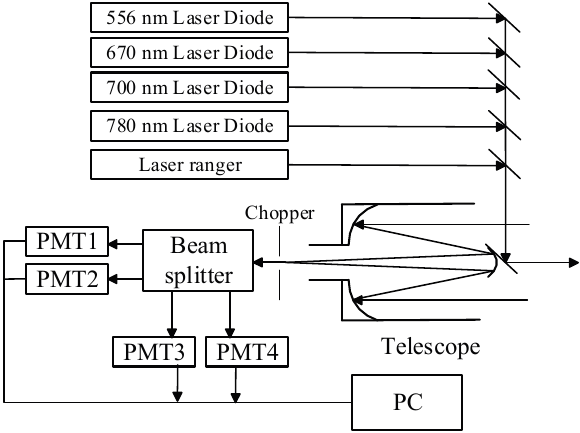
Figure 1. Schematic of the multispectral LiDAR (MSL) system used in this present